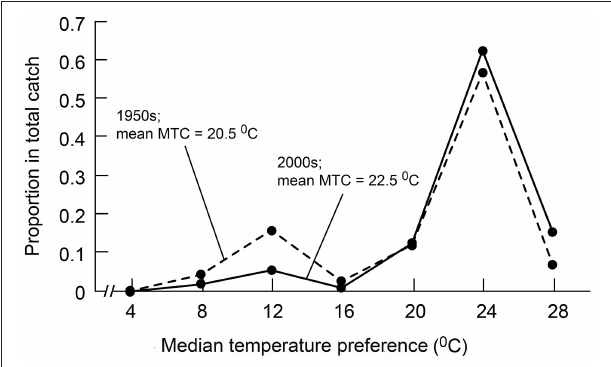
FIGURE 5 | Fisheries catch composition comparison between 1950s and 2000s in the Yellow and East China Seas, illustrating the tropicalization of the fish